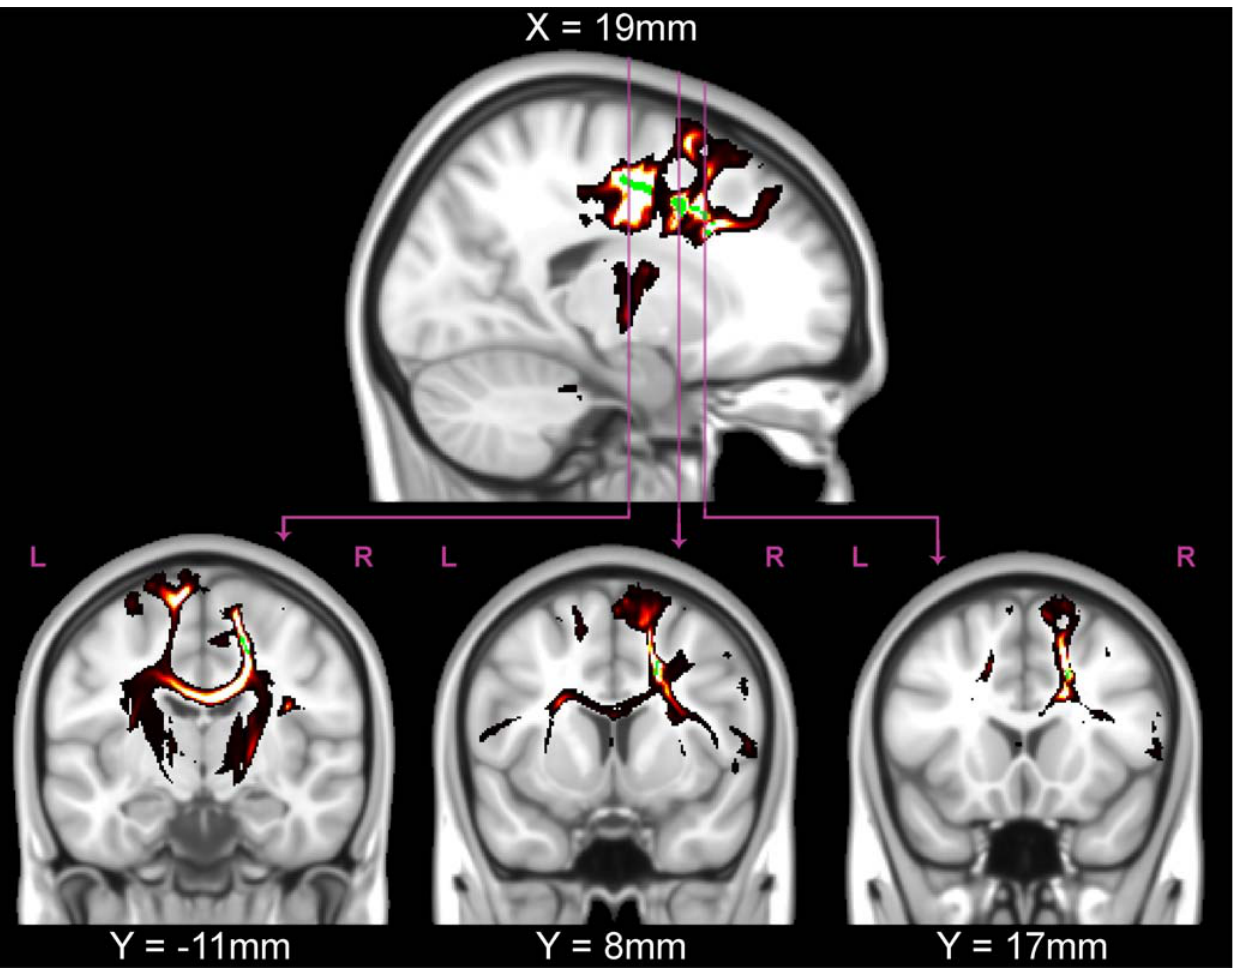
Figure 4. Probabilistic tractography from a typical participant. The significant ( P , 0.05, green ) TFCE-corrected regions from the FA correlation with adjusted-ARQ were used as seeds for tractography in the participant with the median adjusted-ARQ (female, age 16 years). Tractography revealed that the white matter regions that were significantly correlated with FA were located predominately in descending tracts from prefrontal cortex through the internal capsule, interhemispheric fibers connecting left and right homologous regions through the corpus collosum, and fibers connecting prefrontal regions with the temporal lobe ( lower middle ).